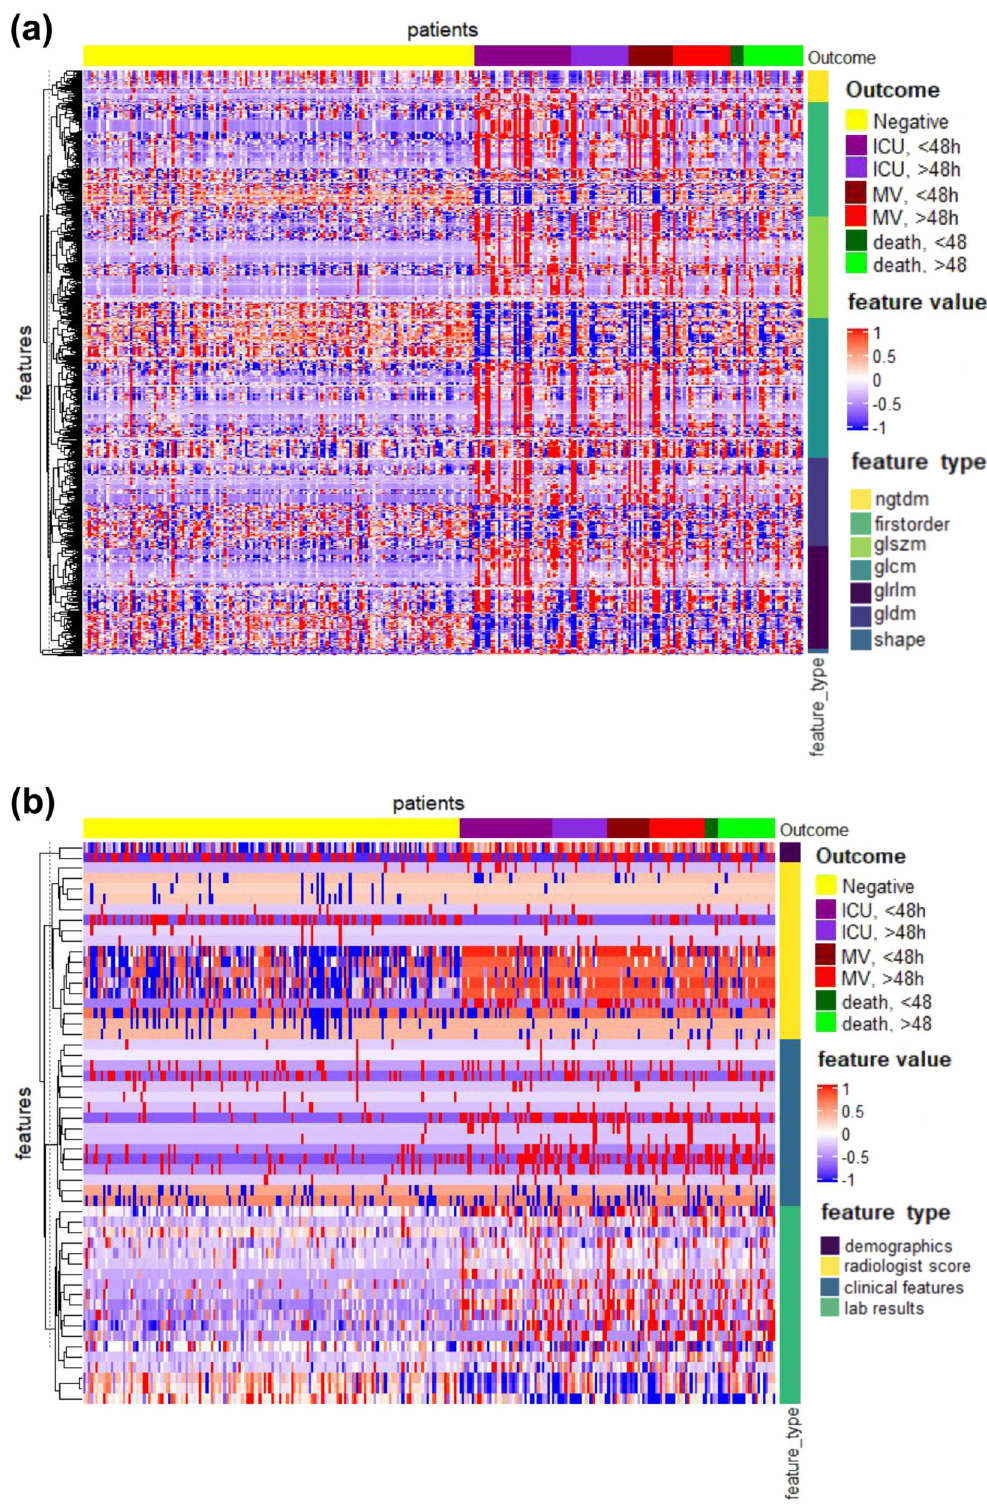
Key imaging features and clinical prognostic indicators Among the top-ranking prognostic indicators, clinical data and radiomics features showed a complementary role with no signi fi cant correlations (Fig. 3, Supplementary Figs. 6 and 7). In clinical data, mean age >65, dyspnea, higher lactate dehydrogenase